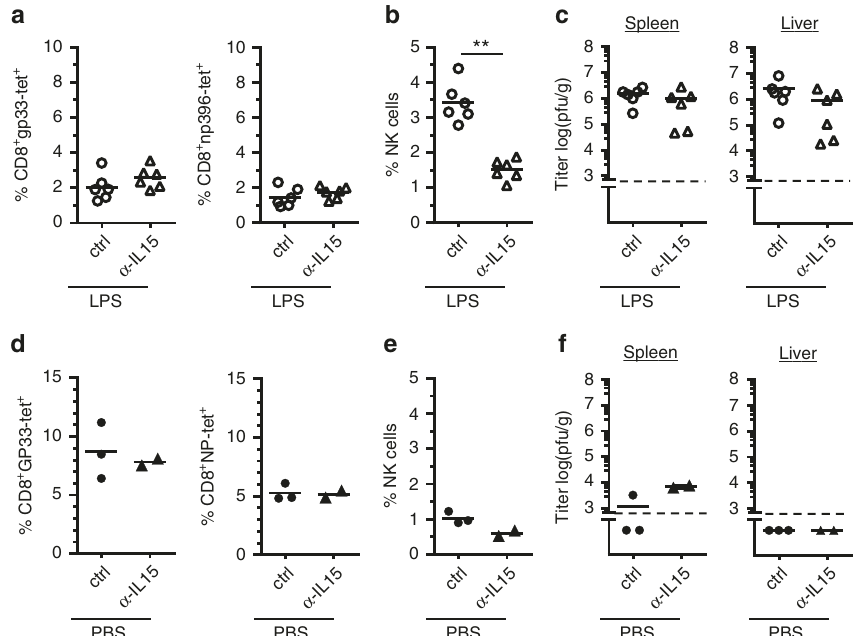
Fig. 5 IL-15 blockade inhibits LPS-induced NK cell accumulation but not negative T-cell regulation. B6 mice were infected with LCMV and received LPS ( a – c ) or PBS ( d – f ) at day 1 p.i.. As indicated, groups of mice were additionally treated at day 1 and day 3 p.i. with mAb speci fi c for IL-15/IL-15R complex. All mice were analyzed at day 8 after LCMV infection. a , d gp33- and np396-tetramer + (tet) CD8 + T cells in percent of spleen cells in the indicated groups. b , e Percent NK cells (CD3 – NK1.1 + ) of spleen cells. ( c , f ) Viral titers in spleen and liver. Data of individual mice from ( a – c ) two independent experiments with three mice per group ( n = 6) and d – f one experiment with 2 – 3 mice per group ( n = 2 – 3) are shown; horizontal bars represent the mean values. Dashed lines indicate detection limits. ** p < 0.01, Mann – Whitney